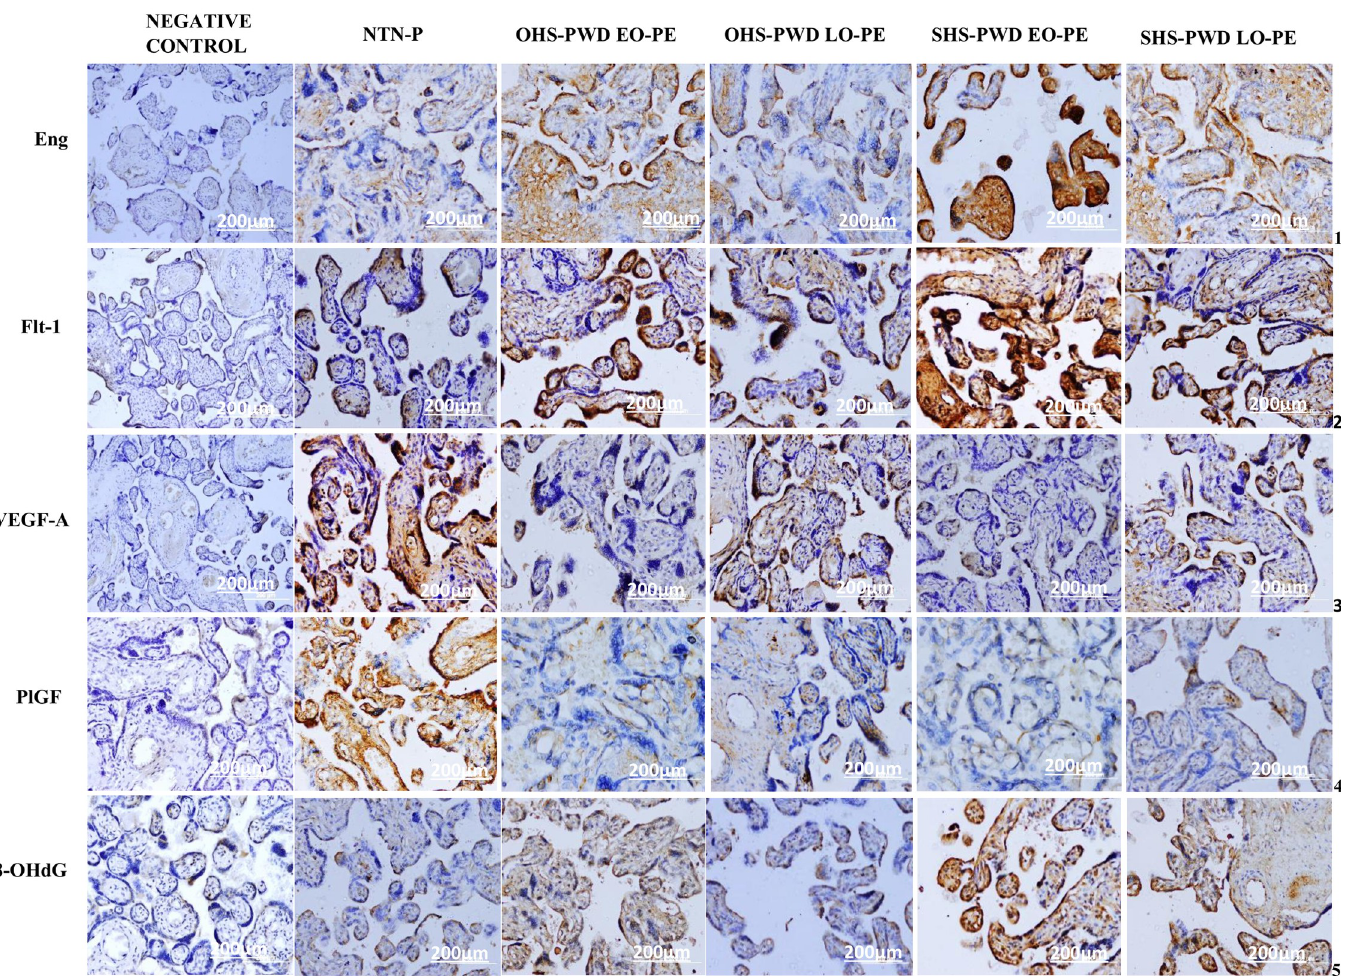
Fig 5. Photomicrographs of the differential expression of pro-AGMs (PIGF and VEGF-A), anti-AGMs (Eng and Flt-1), and oxidative DNA marker (8-OHdG) in placentae from SHS and OHS-PWD EO-PE and LO-PE compared to NTN-P. Negative control showing negative or no IHC staining (column 1). Higher staining intensity/diffuse positivity (high brown staining) of expression of Eng (row 1), Flt-1 (row 2) in cytotrophoblast, syncytiotrophoblast, mesenchymal cells of the villous stroma and syncytial knots of SHS- pregnant women who developed EO-PE at 32 weeks as compared to OHS- pregnant women who developed EO-PE at 32 weeks gestation. Partial positivity (moderate brown staining) expression in SHS- pregnant women who developed LO-PE at 37 weeks, focal positivity (low brown staining) expression in OHS- pregnant women who developed LO-PE at 37 weeks and negative expression in NTN-pregnant women at 38 weeks. Higher staining intensity/diffuse positivity (high brown staining) of expression of VEGF (row 3) and PlGF (row 4) in endothelial cells of foetal capillaries and syncytiotrophoblast of NTN-pregnant women at 38 weeks. Focal positivity (low brown staining) expression in SHS and OHS- pregnant women who developed LO-PE at 37 weeks and negative expression in SHS and OHS- pregnant women who developed EO-PE at 32 weeks. Higher staining intensity/diffuse positivity (high brown staining) of expression of 8-OHdG (row 5) in cytotrophoblast cell nuclei and syncytiotrophoblast of SHS- pregnant women who developed EO-PE and OHS- pregnant women who developed EO-PE at 32 weeks gestation. Partial positivity (moderate brown staining) expression in SHS- pregnant women who developed LO-PE at 37 weeks, focal positivity (low brown staining)/ negative expression in OHS- pregnant women who developed LO-PE at 37 weeks and NTN-pregnant women at 38 weeks (magnification x20). Scale bar = 200 μ